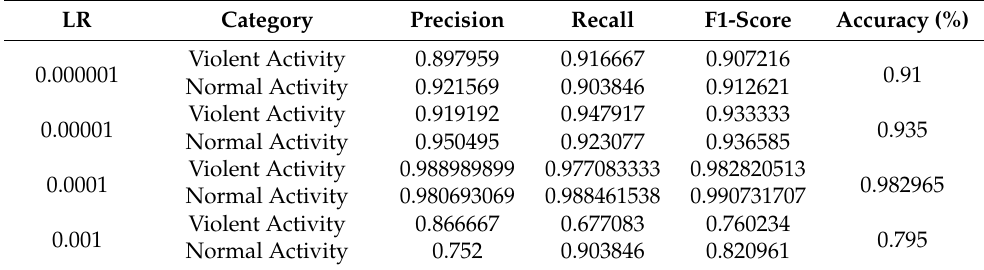
Table 11. Performance of lightweight LSTM